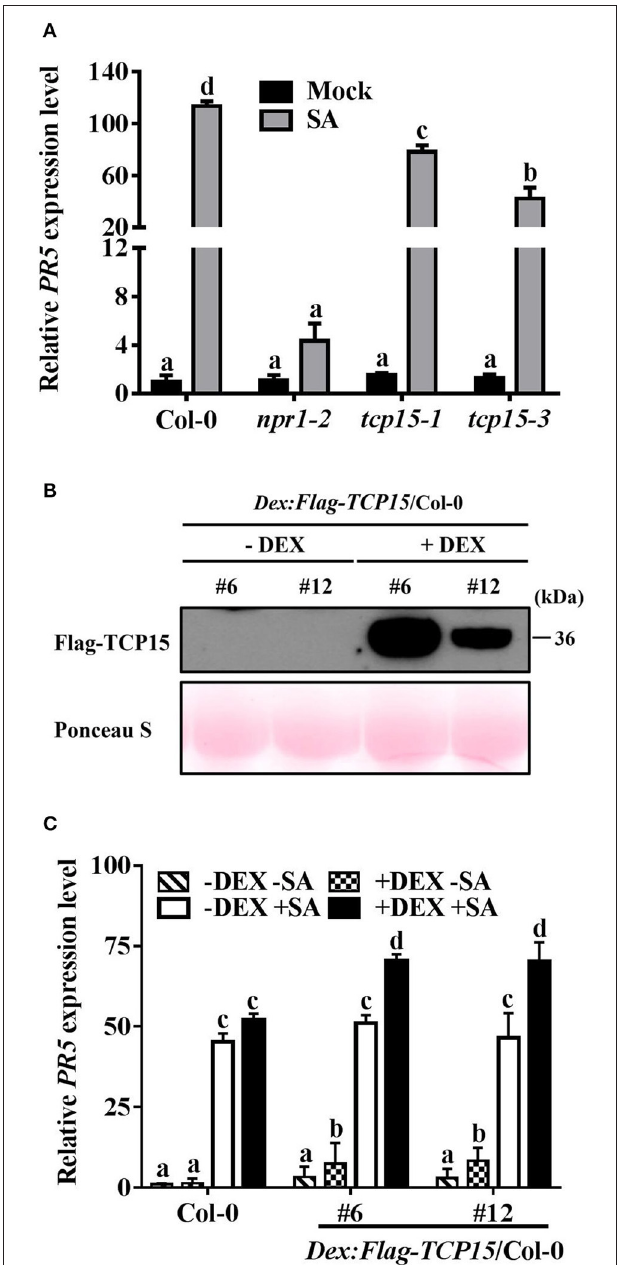
FIGURE 4 | TCP15 regulates the expression of PR5 . (A) The expression of PR5 in Col-0, npr1-2 , tcp15-1 , and tcp15-3 . Twelve-day-old seedlings were treated with water (Mock) or 0.5mM SA (SA) for 24h. The mRNA levels of PR5 were analyzed by RT-qPCR. Values were normalized to the UBQ5 mRNA levels, then to the value of Col-0 (mock), which was arbitrarily set at 1. Statistical analysis was studied by two-way ANOVA following multiple comparisons with turkey test (95% confidence interval) using GraphPad Prism 7. (B) FLAG-TCP15 protein levels in DEX inducible transgenic lines. Two T3 homozygous lines expressing FLAG-TCP15 under control of a DEX-inducible promoter in the Col-0 background ( DEX:FLAG-TCP15 /Col-0) were used. Twelve-day-old seedlings were treated with either 0.01% ethanol (–DEX) or 30 µ M DEX ( + DEX) for 24h. Protein levels were measured